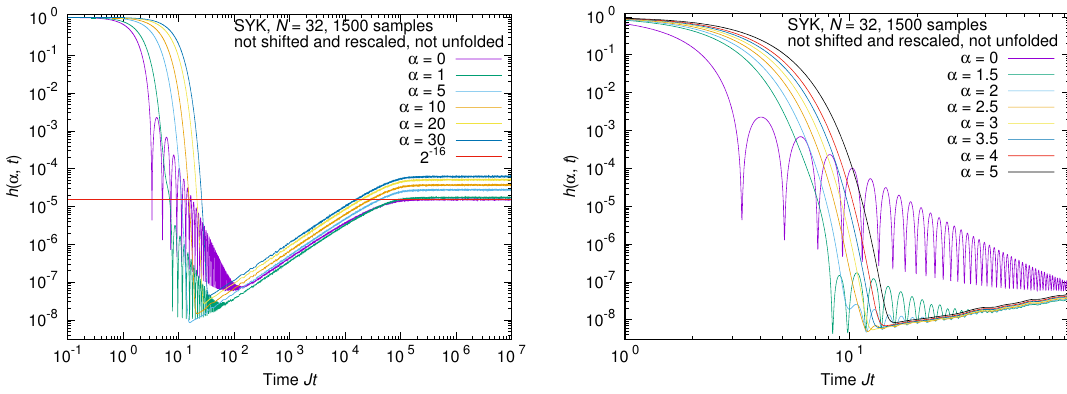
Figure 3 . h ( (cid:11); t ) (cid:17) j Y ( (cid:11); t ) j 2 = j Y ( (cid:11); t = 0) j 2 at N = 32, with various values of (cid:11) . Note that g ( t ) = h ( (cid:11) = 0 ; t ).